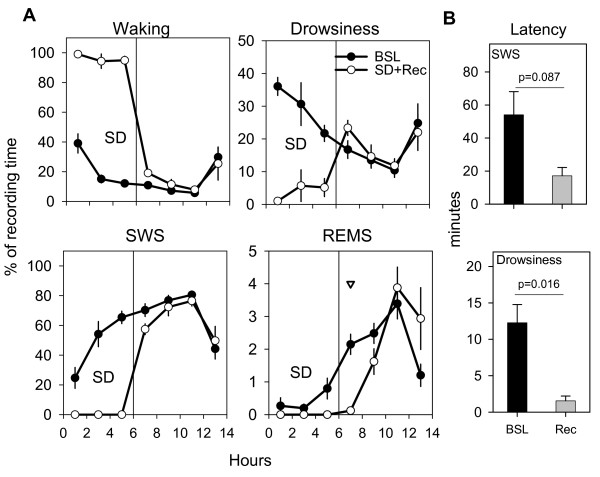
Amount and time course of behavioral states during sleep deprivation and subsequent recovery. A. Amount and time course of vigilance states during 6 hours of sleep deprivation (SD) and the first 8 hours of recovery sleep (Rec) and values during baseline (BSL). Values plotted as mean duration (± SEM, n = 6) of each state in 2-hour intervals expressed as percentage of total recording time. Triangle indicates a significant difference between the duration of vigilance state in BSL versus Rec. B. Latency to the first epoch scored as SWS or drowsiness during BSL and after SD. The latency to drowsiness was defined as the interval between lights-off during baseline or the end of 6 hours of SD and the first epoch of drowsiness. Values are plotted as mean (± SEM, n = 6) number of minutes from dark onset (BSL) or from the end of SD. Note the trend toward a decrease in SWS latency (p = 0.087, paired t-test) and the significant (p = 0.016, paired t-test) decrease in latency to drowsiness after SD.